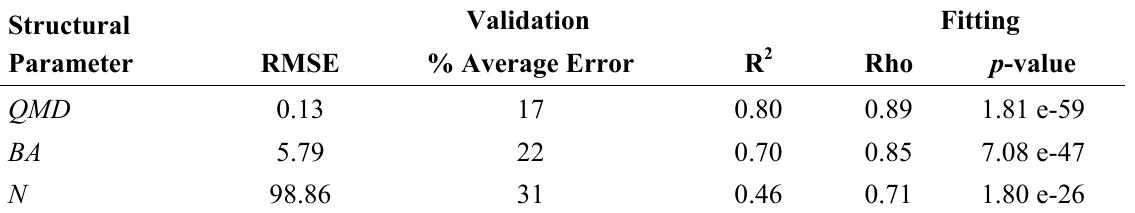
Table 6. Fitting and performance results of the regression tree models for QMD, BA, and N.